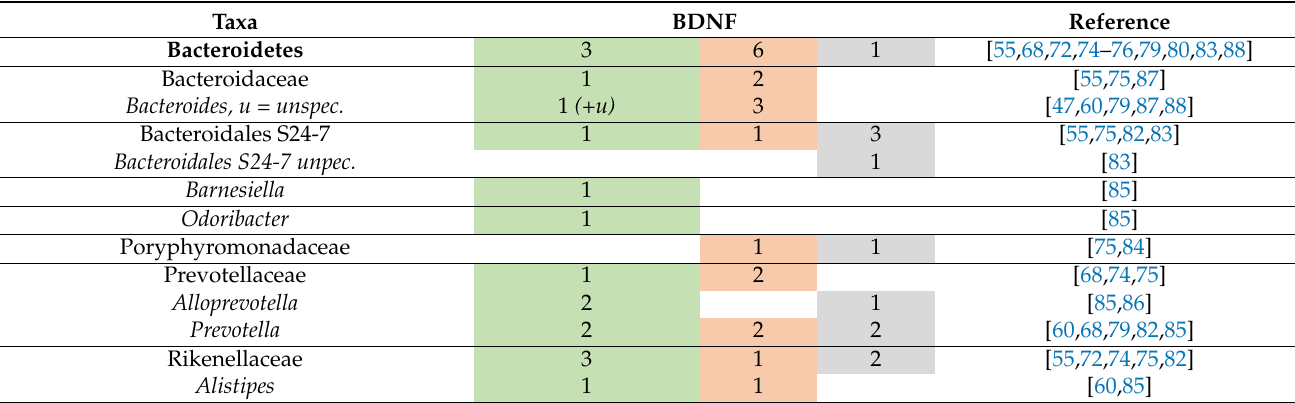
Table 6. Bacteroidetes and